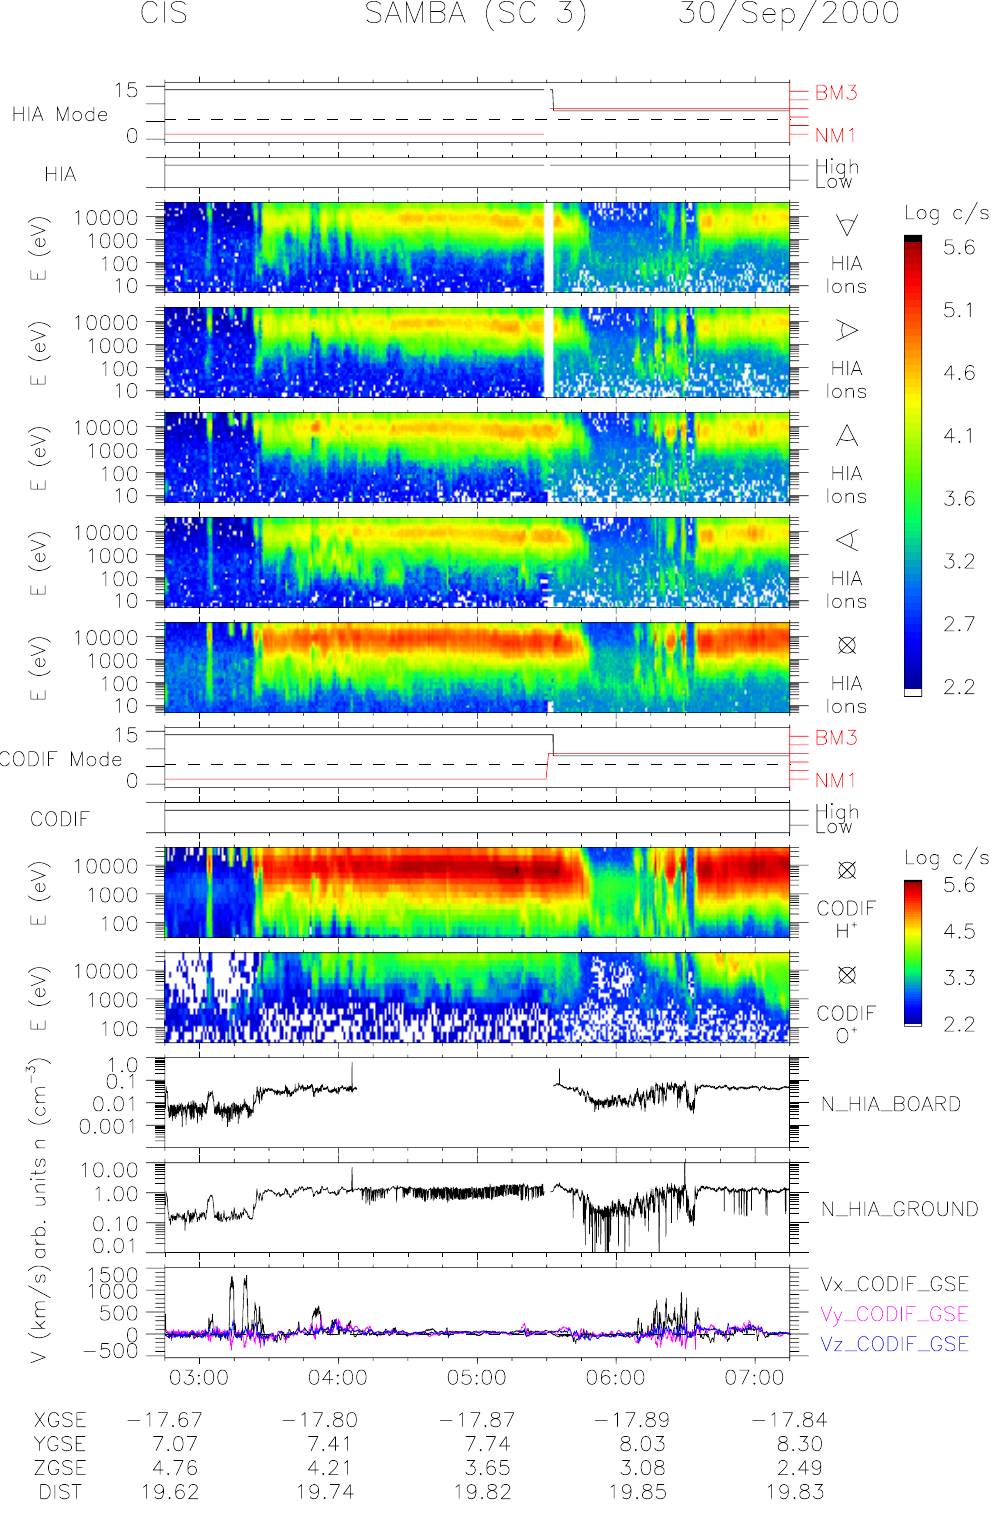
Fig. 21. CPS and near CPS measurements by the CIS experiment on 30 September 2000, between 02:45 and 07:15UT, with spacecraft 3. From top to bottom: HIA telemetry modes and sensitivities, energy-time spectrogram HIA, measured in the sunward, dusk, anti-sunward, dawnward looking directions and integrated over 4 5 , CODIF telemetry modes and sensitivities, H + and O + CODIF energy-time spec- trogram integrated over 4 5 , onboard and ground calculated ion density, from HIA, and onboard GSE velocity components measured by